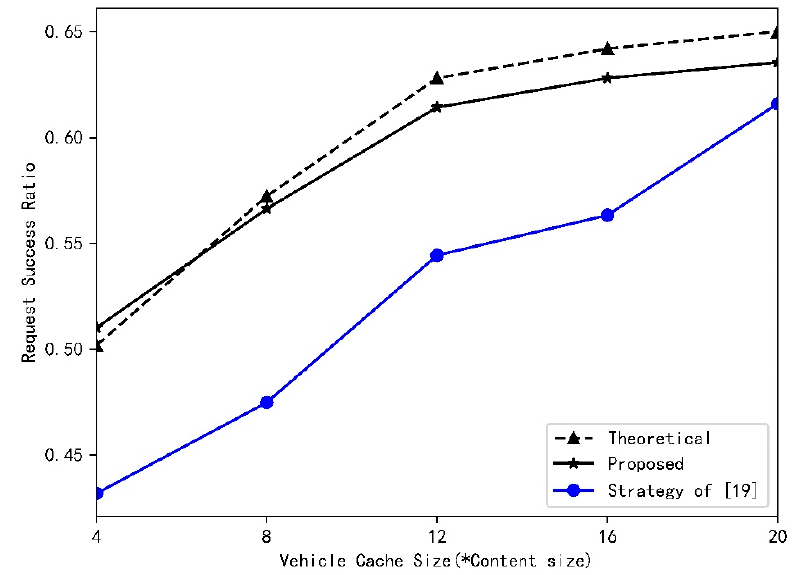
Figure 10. The relationship between the Request Success Ratio and vehicle caching size.